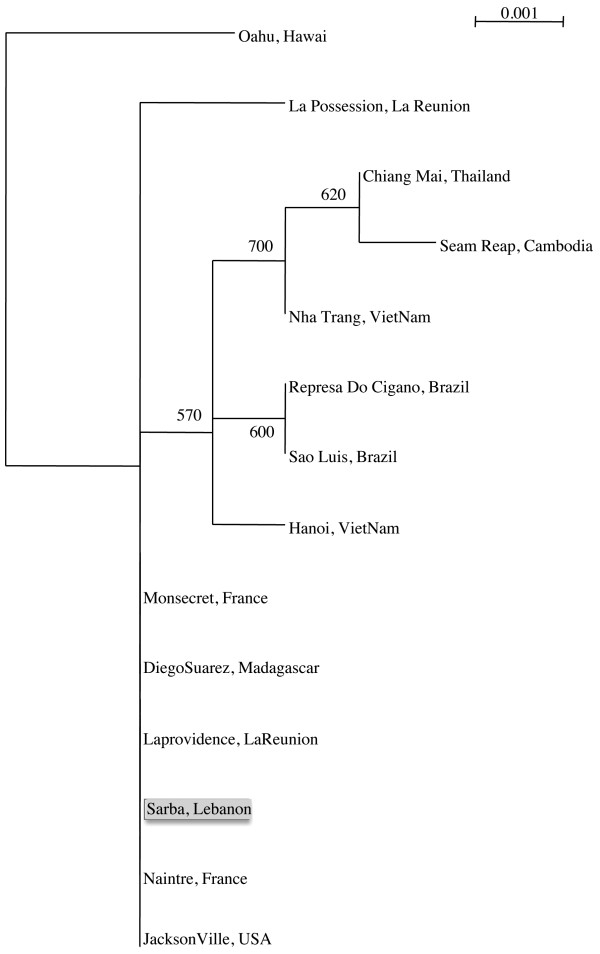
Phylogenetic relationships among Ae. albopictus based on the combined analysis of the three mtDNA genes: cytb, COI and NADH5. The analysis was performed using PhyML (Guindon & Gascuel, 2003). The significance of internal branches was evaluated using 1000 bootstrap replications. The tree includes one Lebanese specimen (Sarba) and 13 others derived from Mousson et al. (2003) which have the following accession numbers for the cytb, COI and ND5 genes: Sarba JX912501, JX912500, JX912502; Represa do Cigano AJ970990, AJ971003, AJ971016; Hanoi AJ970991, AJ971004, AJ971017; Jacksonville AJ970992, AJ971005, AJ971018; Seam Reap AJ970993, AJ971006, AJ971019; Diego Suarez AJ970994, AJ971007, AJ971020; Montsecret AJ970995, AJ971008, AJ971021; Naintre AJ970996, AJ971009, AJ971022; Nha Trang AJ970997, AJ971010, AJ971023; La Possession AJ970999, AJ971012, AJ971025; La Providence AJ971000, AJ971013, AJ971026; Sao Luis AJ971001, AJ971014, AJ971027; Chiang Mai AJ971002, AJ971015, AJ971028 and Oahu AJ970998, AJ971011, AJ971024, used as outgroup.